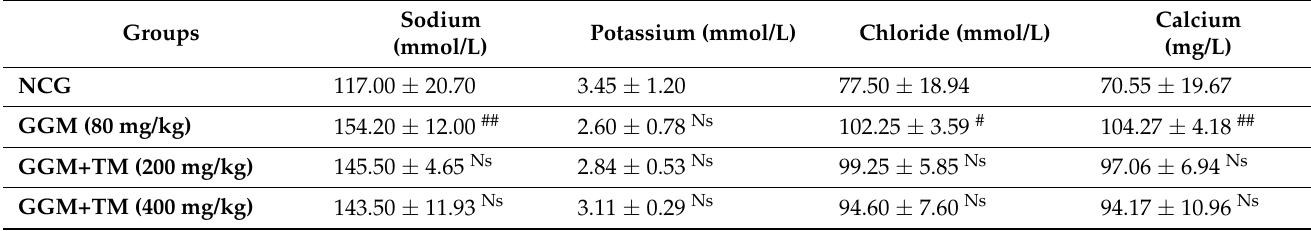
Table 4. Effect of APTM extract on serum electrolyte amounts in GM-exposed rats.